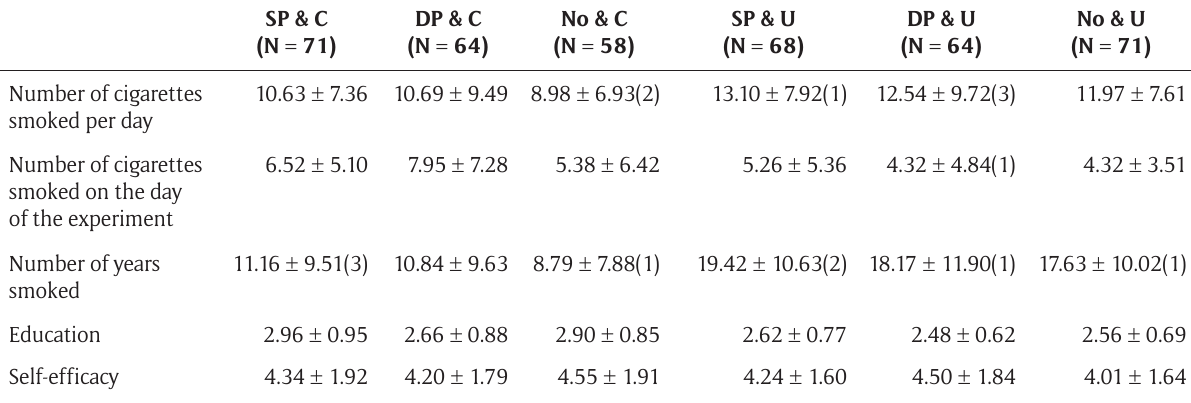
Table 4: Mean scores and standard deviations on secondary variables of Study